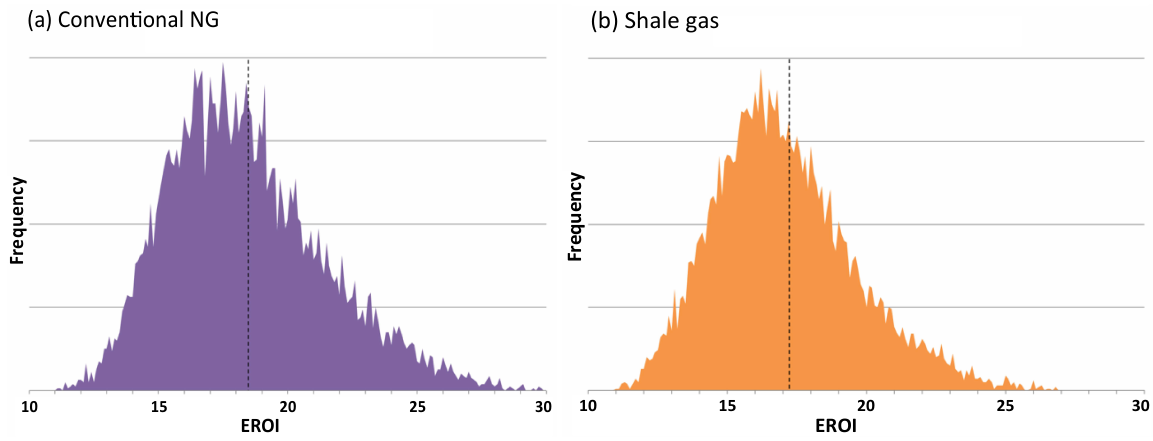
Figure 3. Statistical distributions of (cid:1831)(cid:1844)(cid:1841)(cid:1835) NG, and ( b ) shale gas. The broken line indicates the mean value of